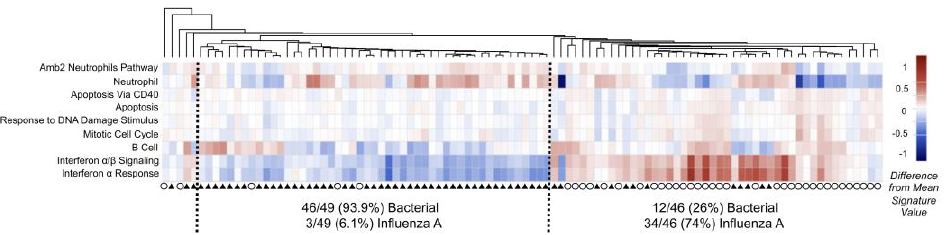
Figure 2. SaVanT visualization for expression data from patients with acute infections (influenza A—circle; bacterial pneumonia—triangle) [28].